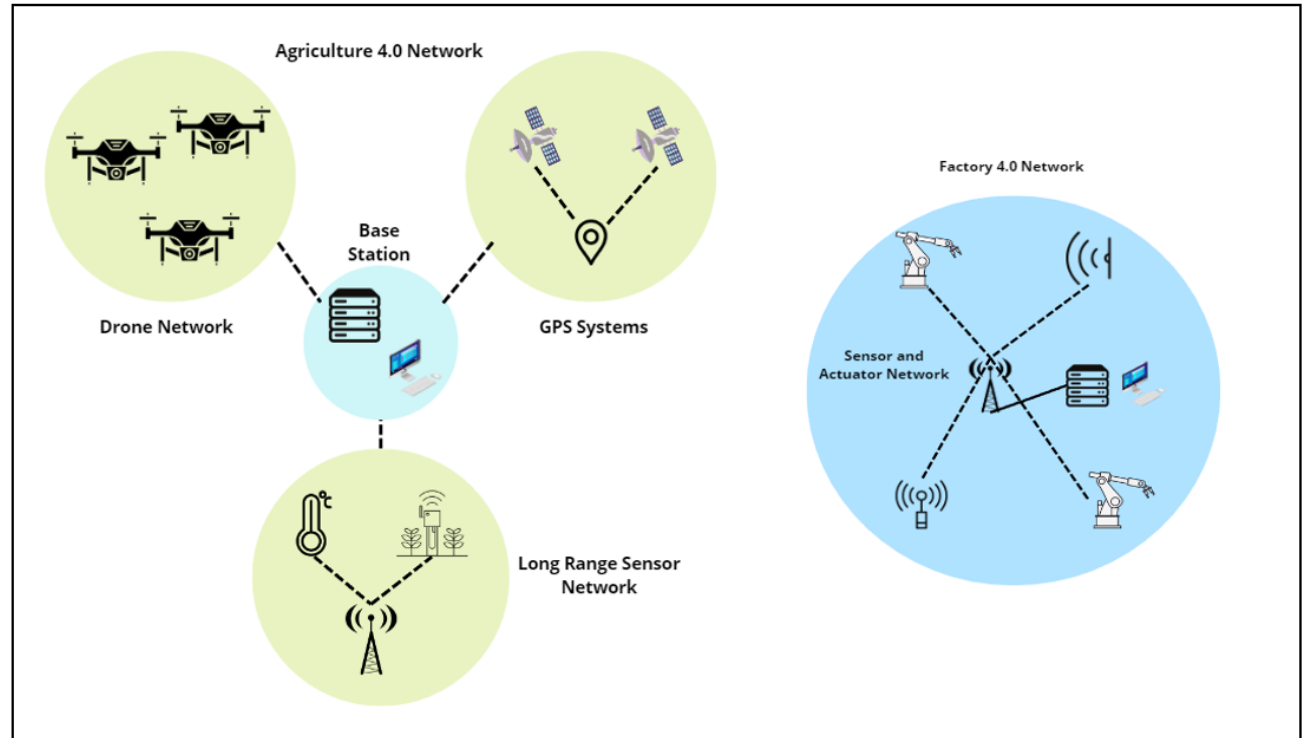
Figure 2. Comparison of Agriculture and Factory 4.0 proposed network structures .